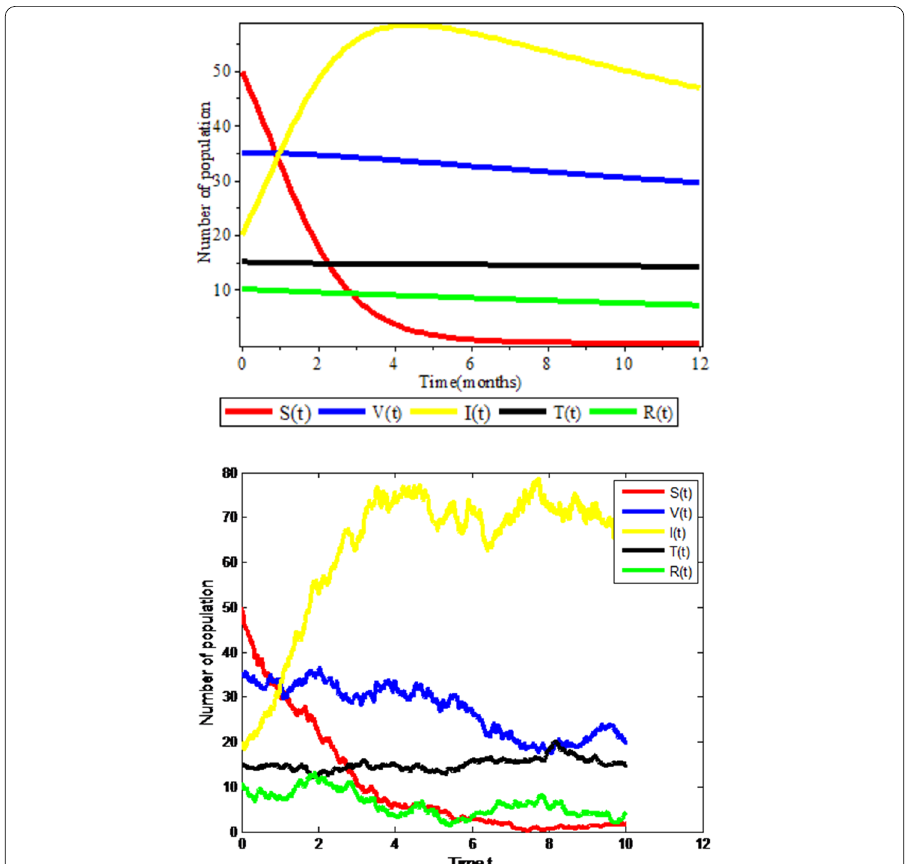
Figure 2 Graphs of deterministic and stochastic Covid-19